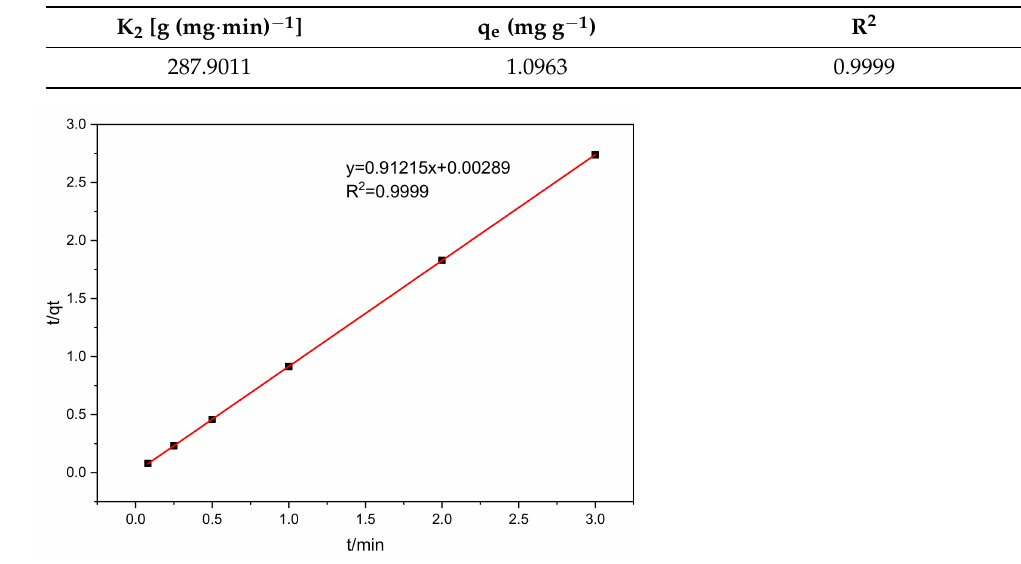
Figure 7. Simulation of kinetics data by pseudo-second-order kinetic model.